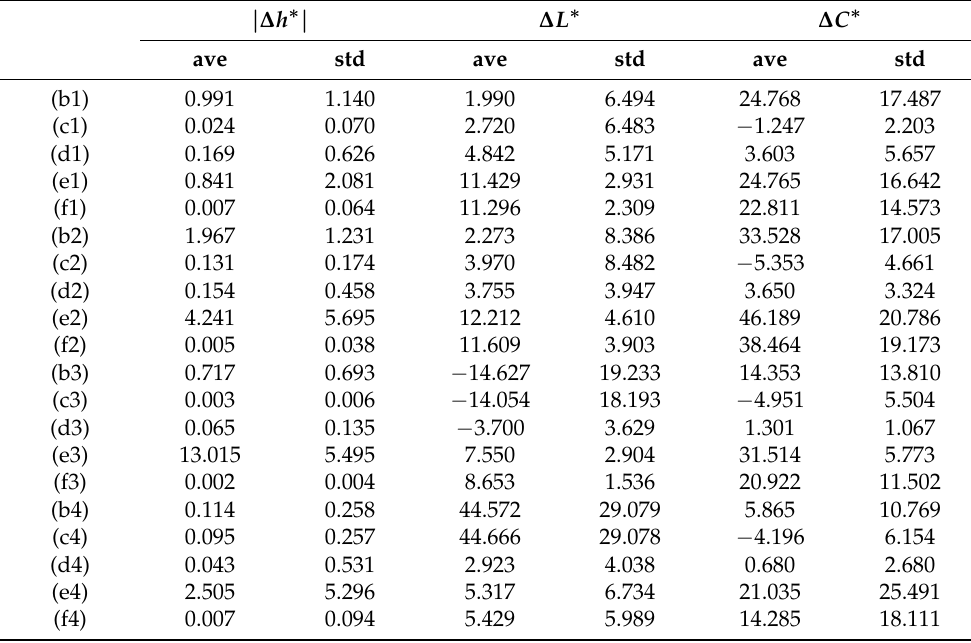
Table A2. Averages and standard deviations of | ∆ h ∗ | , ∆ L ∗ , and ∆ C ∗ in Figure